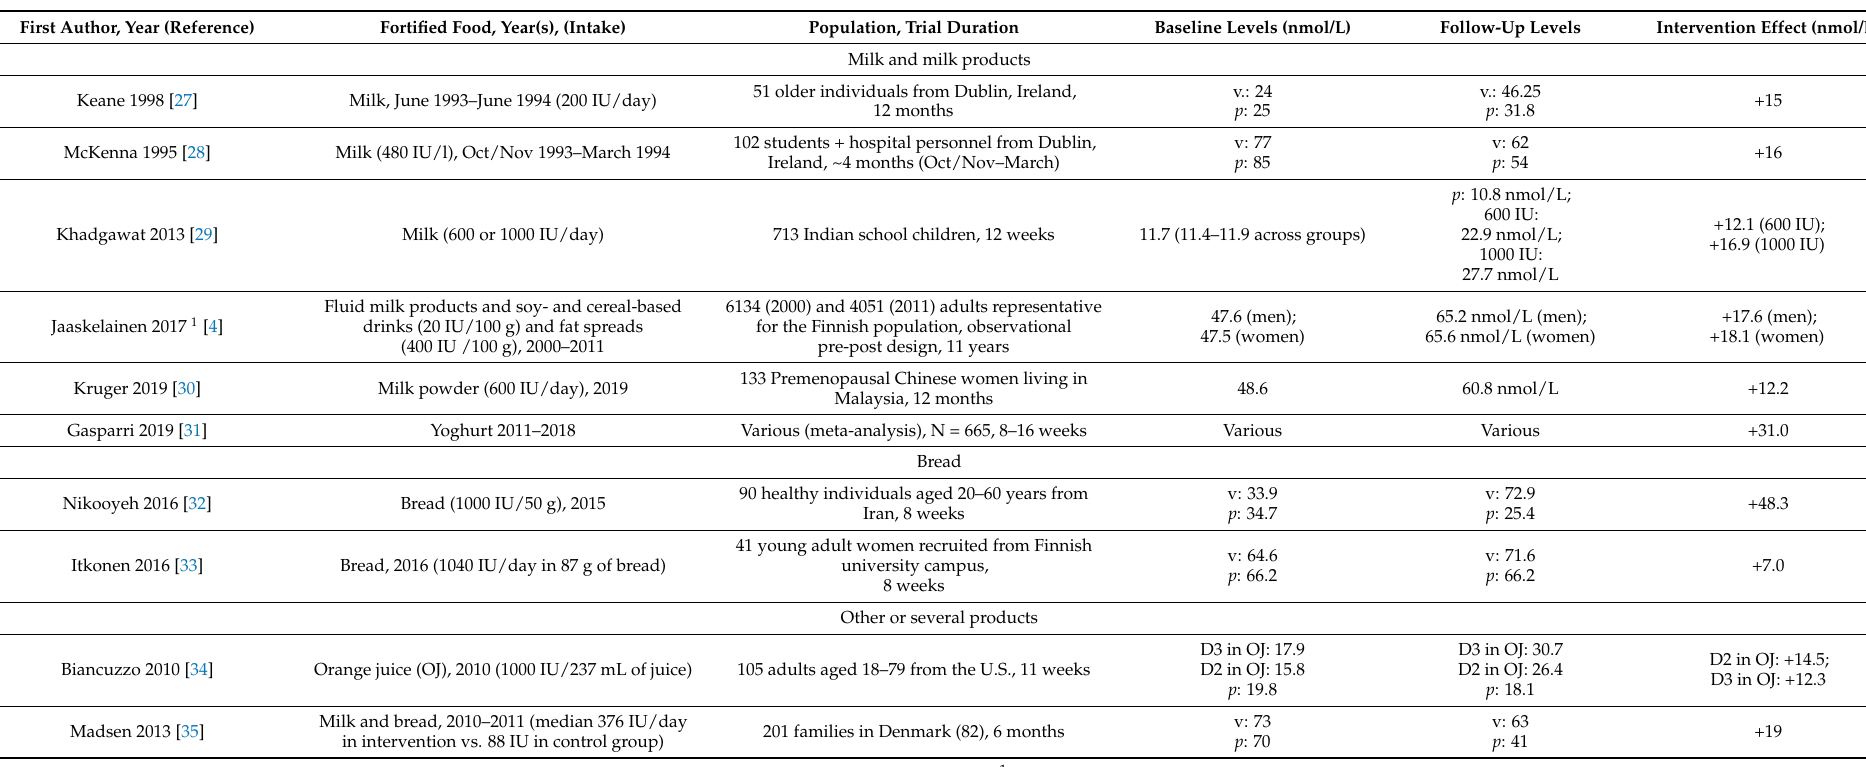
Table 3. Effects of vitamin D food fortification and supplementation ((v)erum/( p )lacebo) on serum vitamin D levels, sorted by year of publication within each food